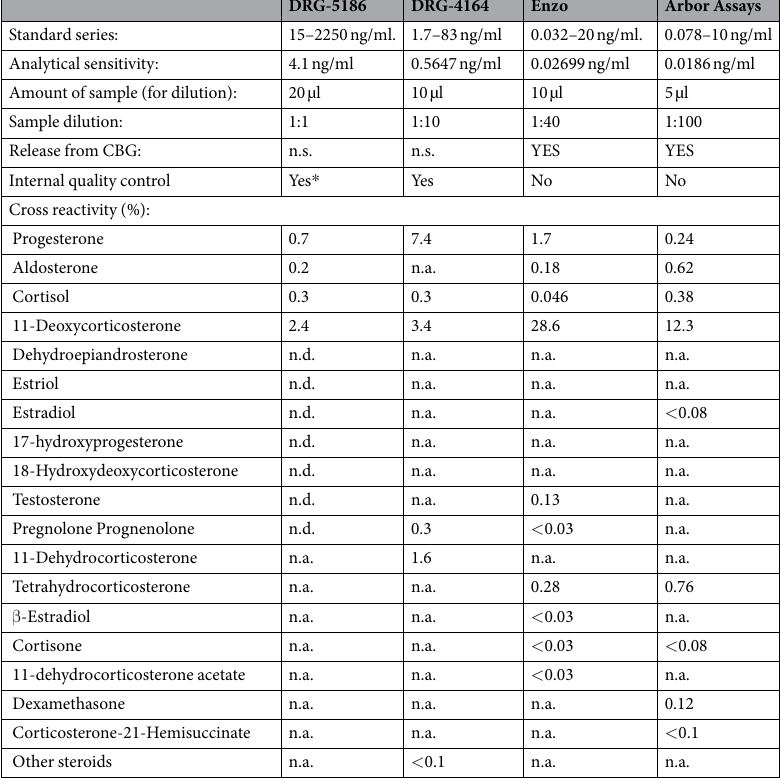
Table 1. Information from manufacturers kit manual and included in the kits. * Recommended quality control kit (DRG CTL-5262). CBG -Corticosteroid-binding globulin; n.s. not specified in the manual; n.d. cross reactivity not detected for these substances; n.a. the cross reactivity is not assessed for these substances.